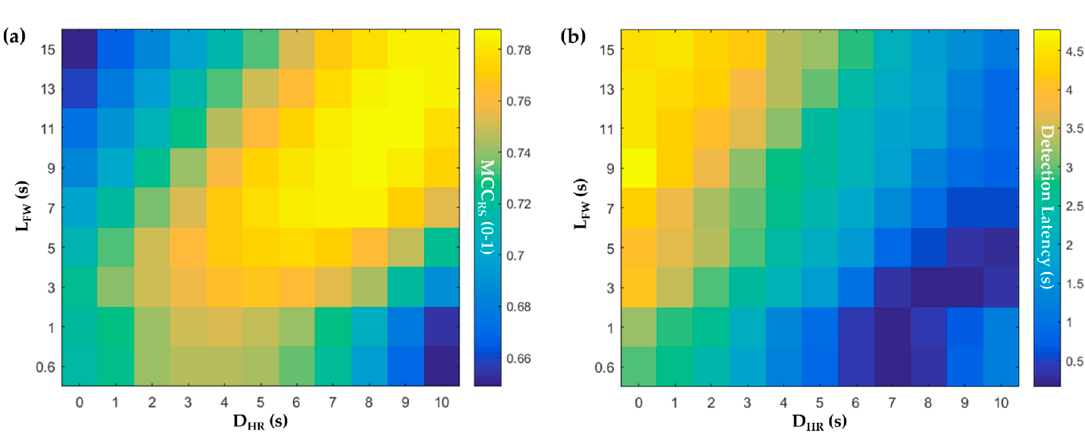
Figure 3. Classification Performance according D HR and L FW : ( a ) The Matthews Correlation Coefficient (MCC) RS map according to D HR (s) and L FW (s); ( b ) The map of detection latency according to D HR and L FW . The pixel values of the detection latency map were calculated on the basis of assumed delay in hemodynamic response. Thus, for true detection latency values, the corresponding D HR must be added to each pixel value. Note that each pixel is the average from the seven participants. The pixel values for both maps are given in Table S1 (Supplementary Materials).